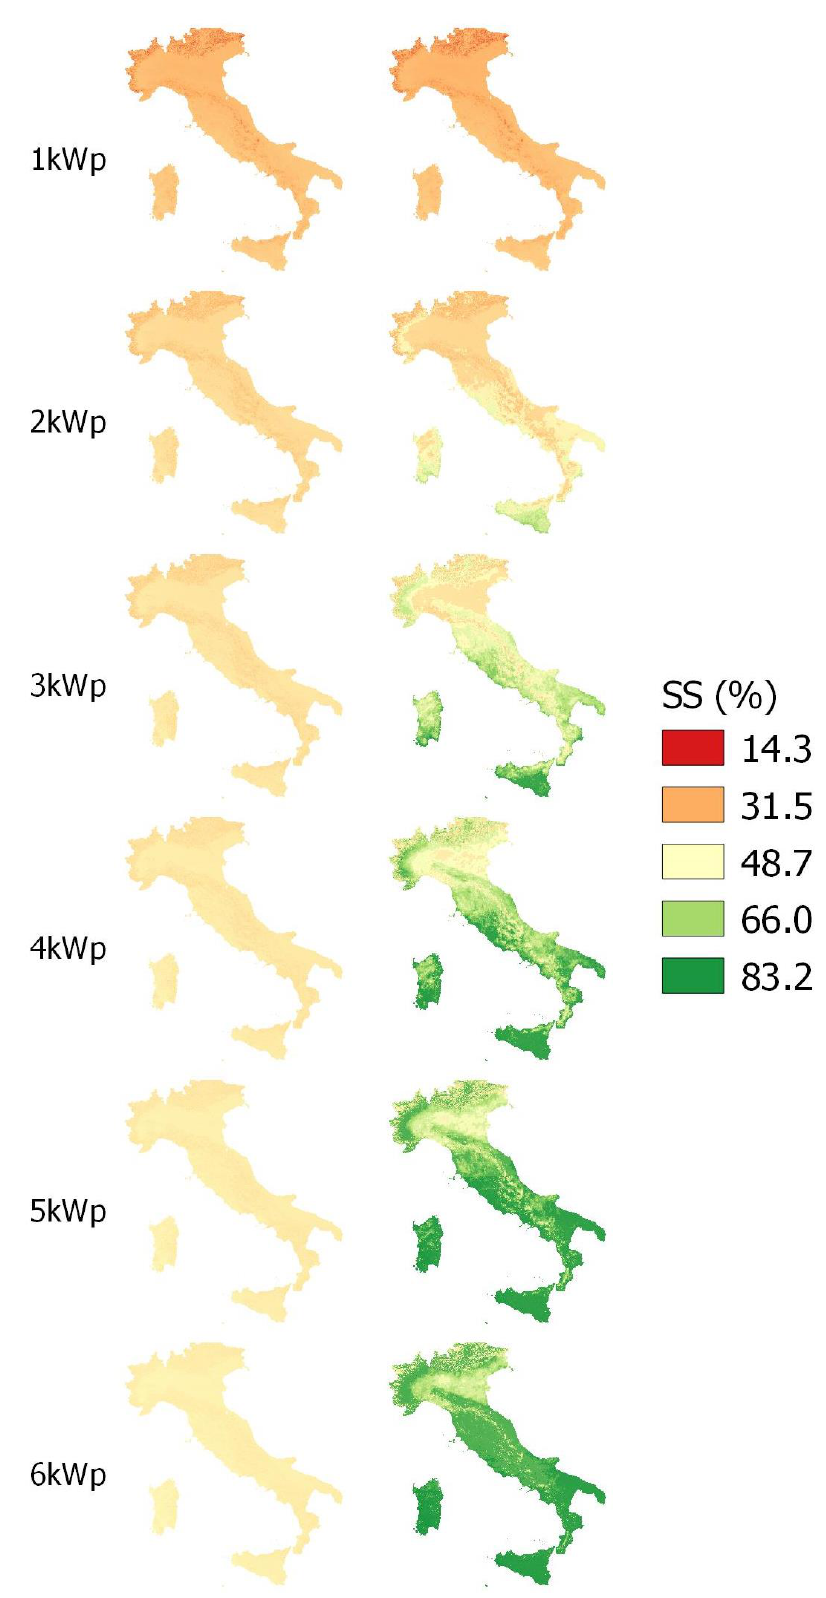
Figure A8. SS for E L = 2700 kWh, left side without battery and right side with